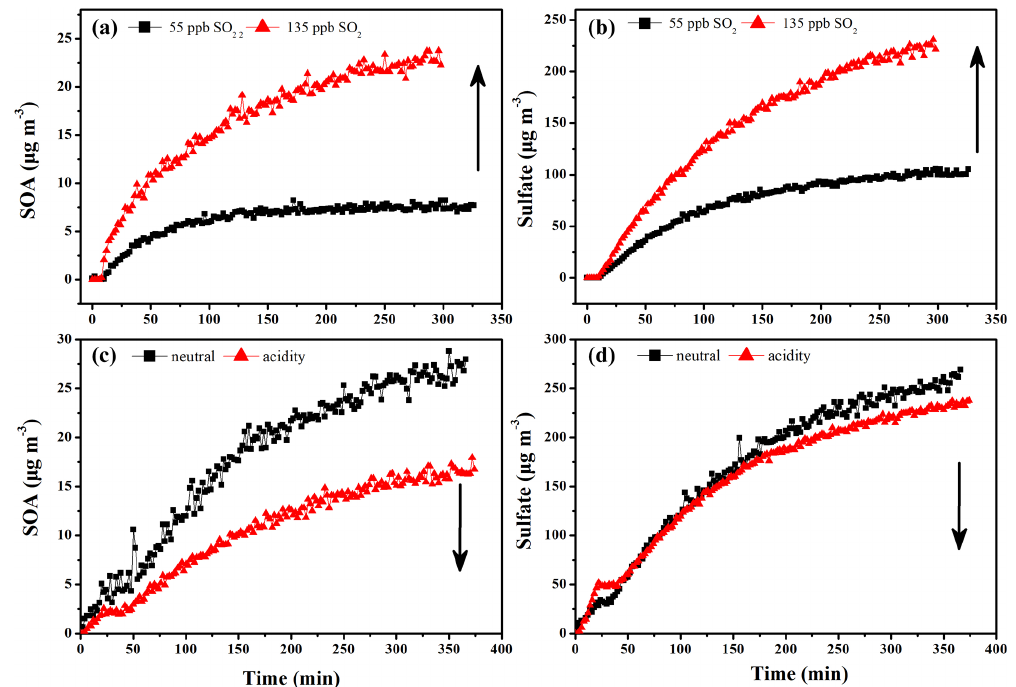
Figure 1. Time-dependent growth curves of SOA (a) and sulfate (b) under different initial concentrations of SO 2 in absence of seed particles; SOA (c) and sulfate (d) after subtracting seeds in presence of neutral and acidic seed